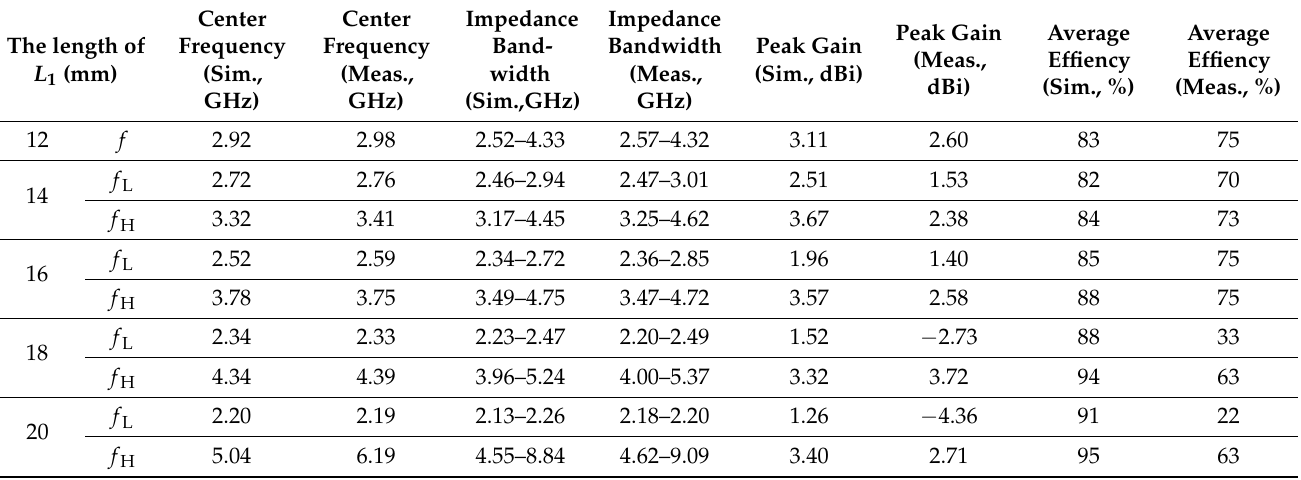
Table 3. The performances of the antenna (the initial condition: L 1 = L 2 = 12 mm).